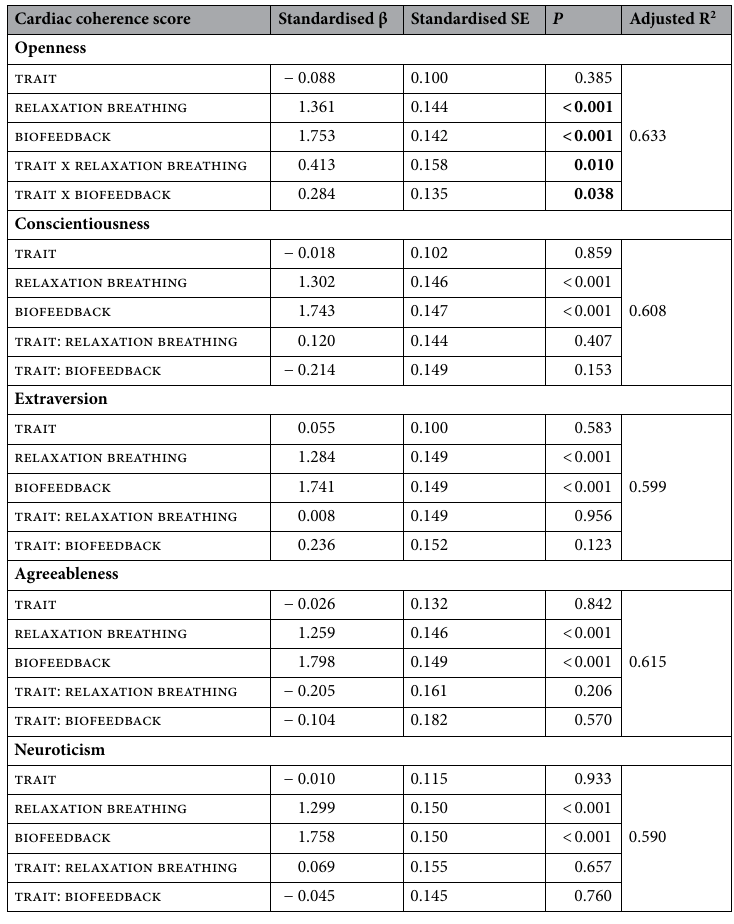
Table 4. Adjusted regression models for each personality trait and cardiac coherence (n = 118). Significant relationships of the model analyses are in bold. SE is the standard